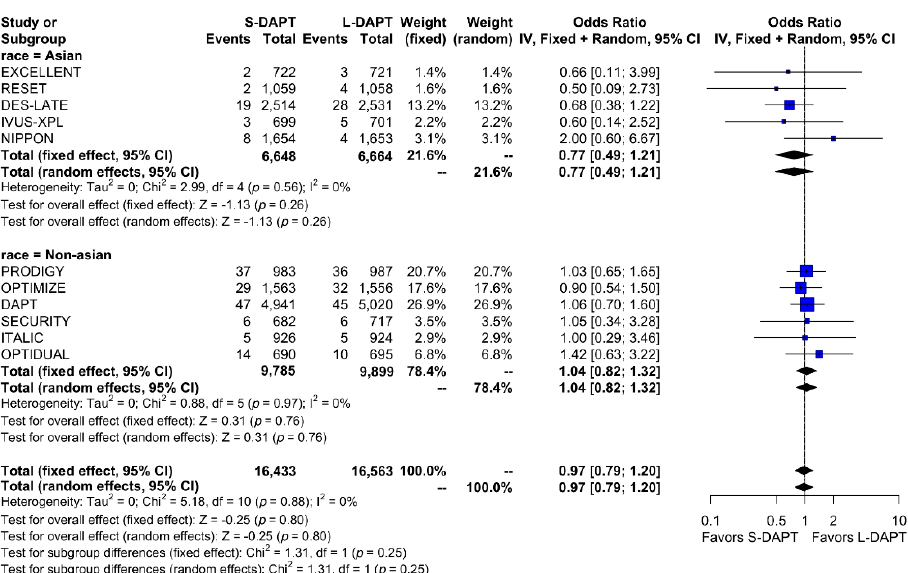
Figure 4. Cardiac death in randomized clinical trials. S-DAPT, short duration dual antiplatelet therapy; L-DAPT, long duration dual antiplatelet therapy; CI, confidence interval.